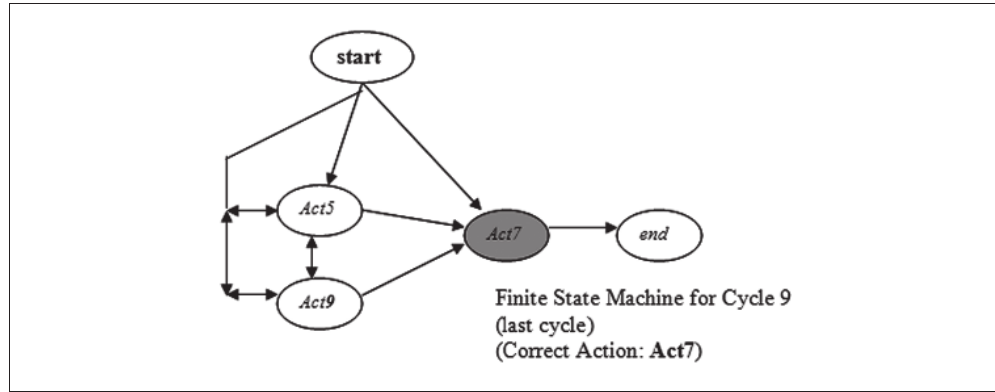
Figure 7 FSM for the last cycle Note: Act n in Figure 6 and Figure 7 refers to the “action button” identifier in the action